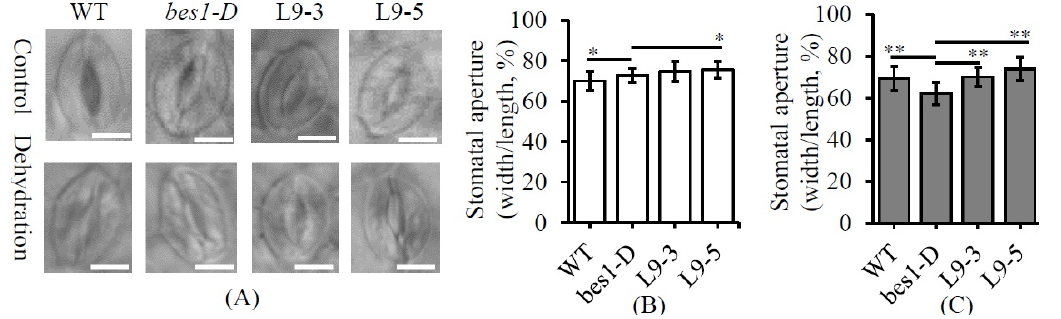
Figure 8. The stomatal phenotype. ( A ) The stomatal morphology. ( B ) The stomatal aperture before dehydration. ( C ) The stomatal aperture after 1 h of dehydration. The leaf of every line was detached for 1 h of dehydration treatment and used to measure the stomatal aperture. All values are means (±SD) of three biological replicates. L9-3 and L9-5 are transgenic lines. bes1-D , mutant. WT, wild type. * and ** represents p < 0.05 and p < 0.01, respectively. The scale bar was 10 μ m.